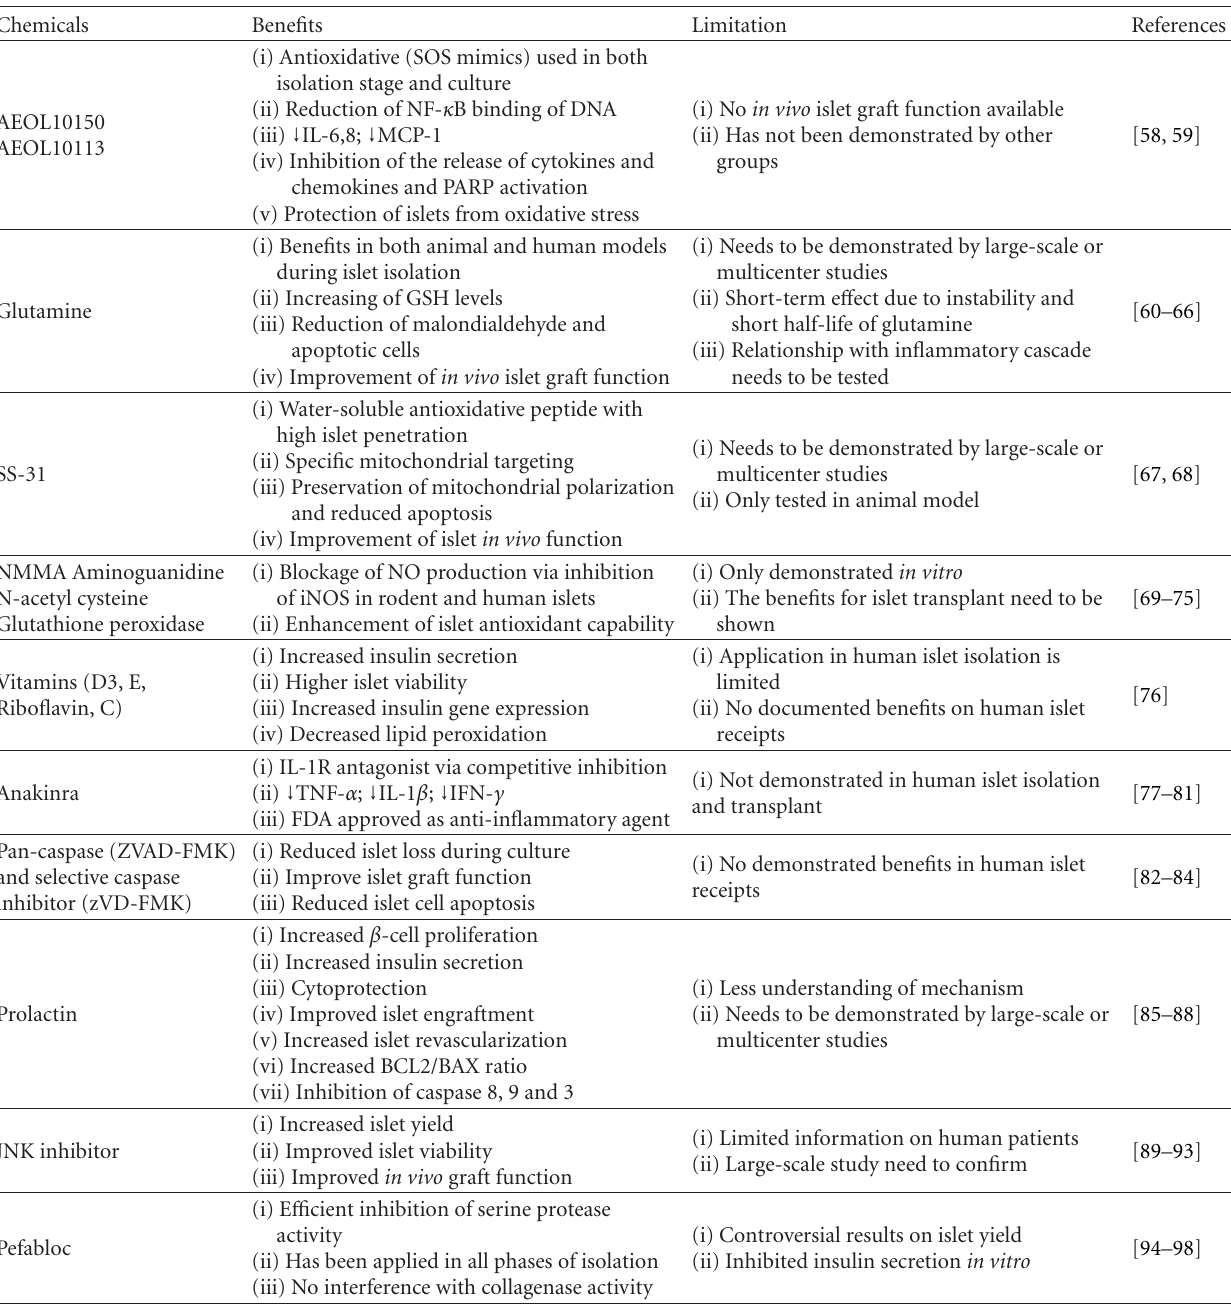
Table 2: Major anti-oxidative and anti-inflammatory chemicals used in pancreas preservation, islet isolation, and islet culture.